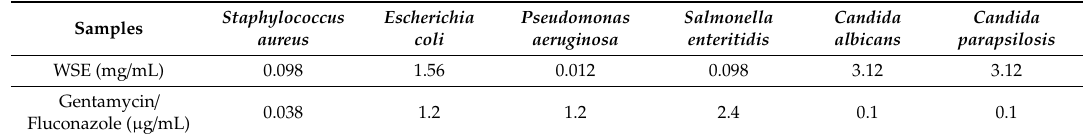
Table 4. Minimum Inhibitory Concentration (MIC) for the walnut septum